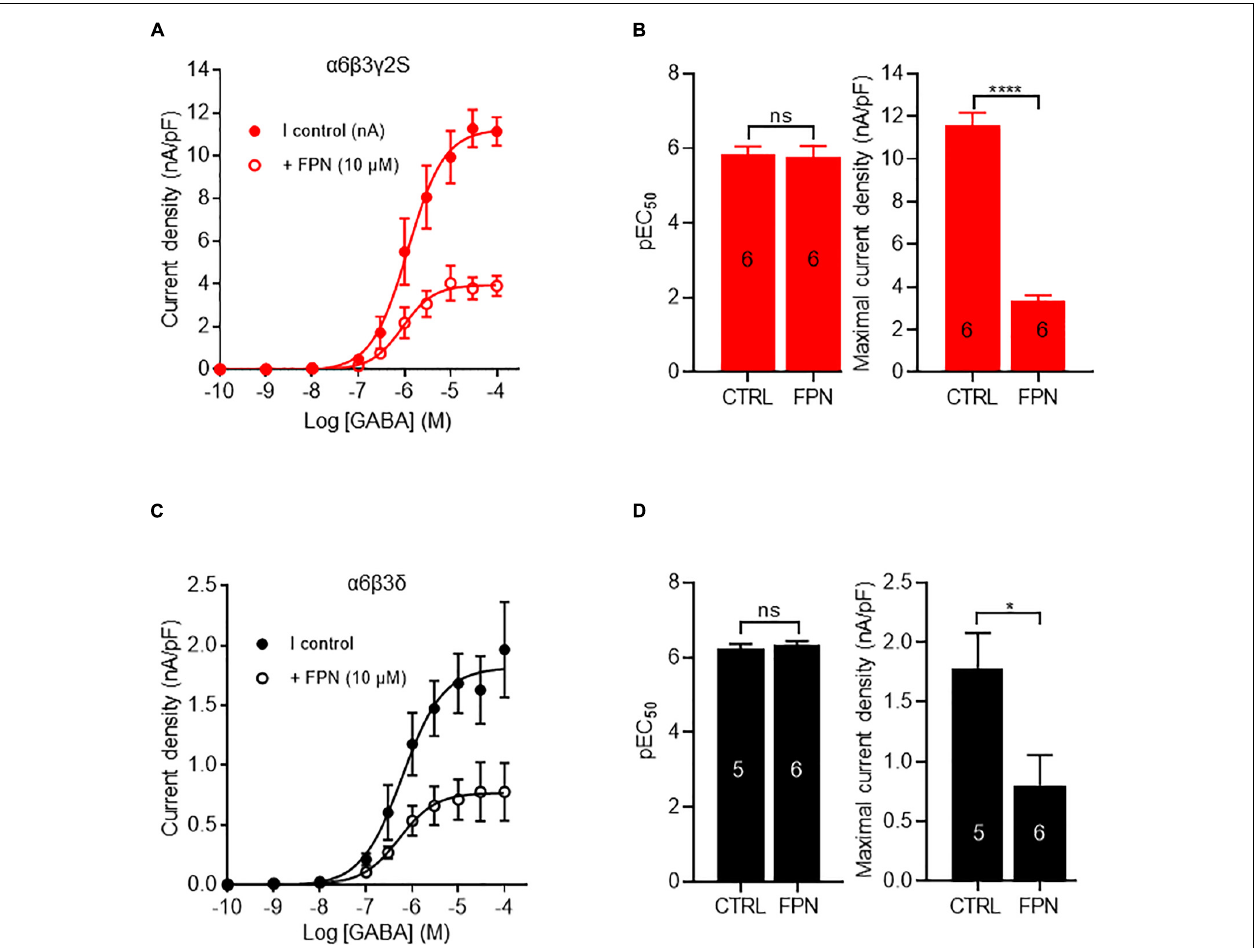
FIGURE 4 | FPN effects on GABA-induced currents elicited by α 6 β 3 γ 2S and α 6 β 3 δ GABA A Rs. (A,C) Concentration-response curves for α 6 β 3 γ 2S and α 6 β 3 δ GABA A Rs. Data were best fitted by non-linear regression to the Hill equation with variable slope. (B,D) Comparison of EC 50 and GABA-currents densities obtained with α 6 β 3 γ 2S (B) and α 6 β 3 δ (D) GABA A Rs, in control (CTRL) and in the presence of FPN (10 µ M). For α 6 β 3 γ 2S, pEC 50 was 5.83 ± 0.21 without FPN and 5.77 ± 0.28 with FPN; E max was 11.6 ± 0.6 pA/pF without FPN and 3.4 ± 0.2 with FPN. For α 6 β 3 δ , pEC 50 was 6.24 ± 0.12 without FPN and 6.33 ± 0.10 with FPN; E max was 1.8 ± 0.3 pA/pF without FPN and 0.8 ± 0.2 with FPN. The number of recorded oocytes is indicated inside the bars. For both receptors, the normality of maximal current density distribution was validated using Shapiro-Wilk test and data were analyzed with unpaired t -test. EC 50 values did not